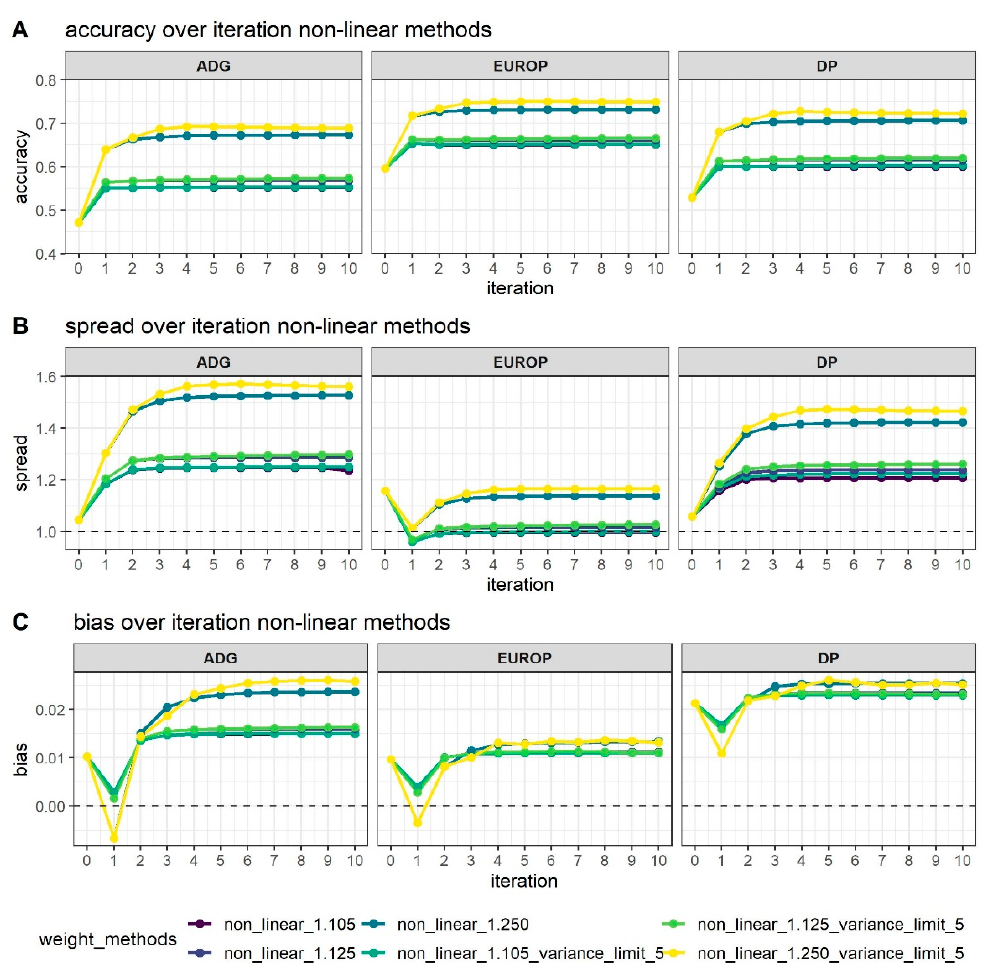
Figure 2. Accuracy ( A ), dispersion ( B ), and bias corrected by genetic standard deviations ( C ) of breeding value estimated using different weighting strategies along the 10 iterations process of the algorithm used in WssGBLUP. The dotted line in Graphs B and C represents the expected value. As expected, higher accuracy (Figure 2A) was reached in the WssGBLUP analyses with the increase of the number of iterations, although in most cases, the asymptote was reached at the second iteration, with the only exception of the CT 1.25 with the limit of